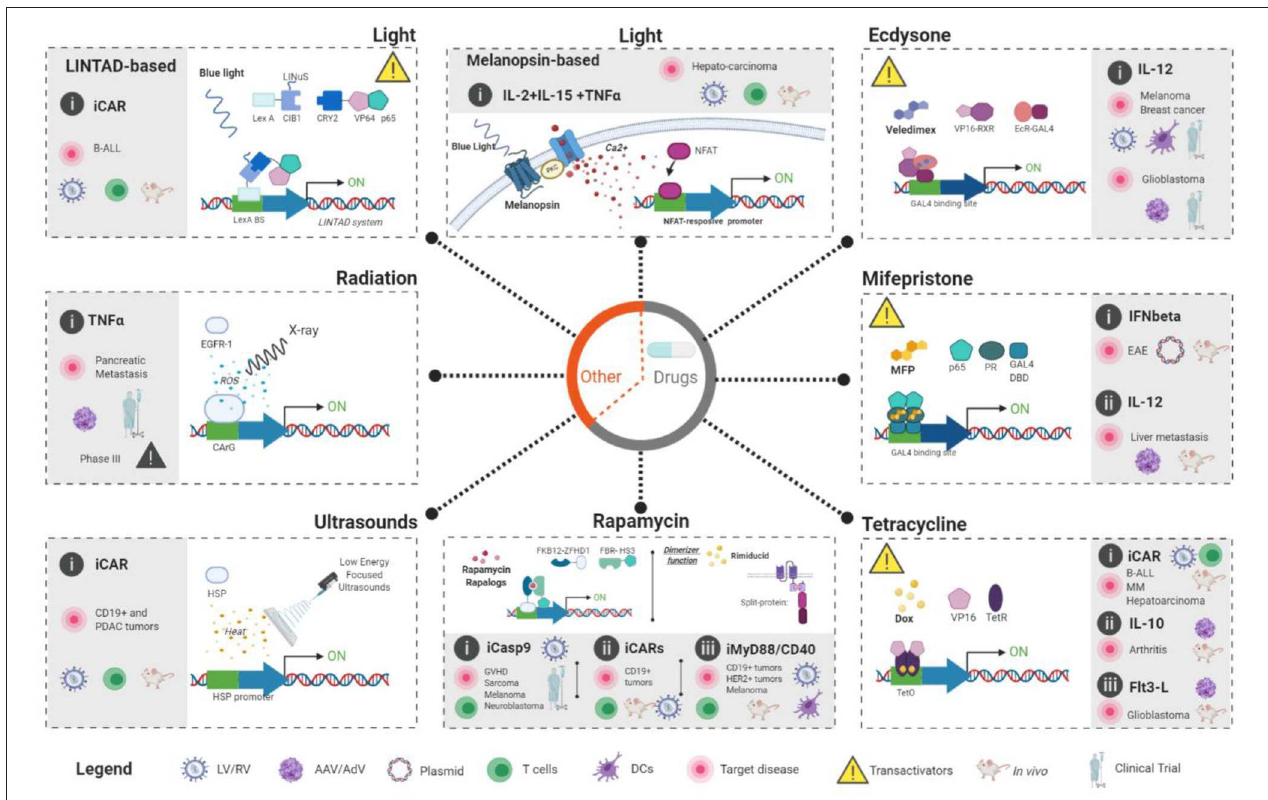
FIGURE 2 | Externally-controlled inducible systems applied to immunogene therapy applications. Two main groups can be established: (1) Drug-based systems (Gray circle in the middle) which include ecdysone, mifepristone, tetracycline, and rapamycin systems. In these systems, clinicians could control the activity of the immunogene therapy through the administration of a drug that will, usually, activate the expression of the desired transgenes. (2) Physical-based systems include two light-based (melanopsin-based and LINTAD), one radiation-based (TNFerade) and one ultrasound-based (FUS-CAR). White area of the each dashed-line square shows the rational of each approach to achieve externally-controlled transgene expression. Key molecular players (inductors and regulatory-proteins) in each system are also indicated. Gray area inside the dashed-line squares indicate published immunogene therapy approaches for each system and the current status; In vitro studies (indicated by the absence of a mice or human drawing), in vivo studies (indicated by the presence of a mice) and clinical trials (indicated by a drawing of human figure). In addition, the target disease, therapeutic gene, modified cells and vector type are also shown. The legend at the bottom of the figure illustrate the meaning of the different symbols used in the figure. Figures were created with